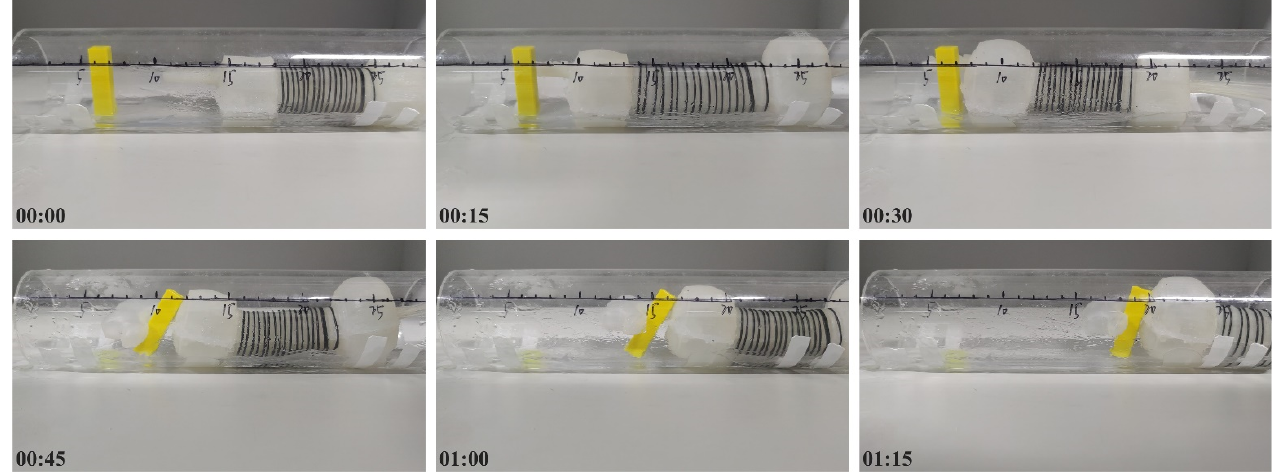
Figure 10. The intestinal soft robot moves inside a mucus-containing pipe. (The number represents the running time of the soft robot.)